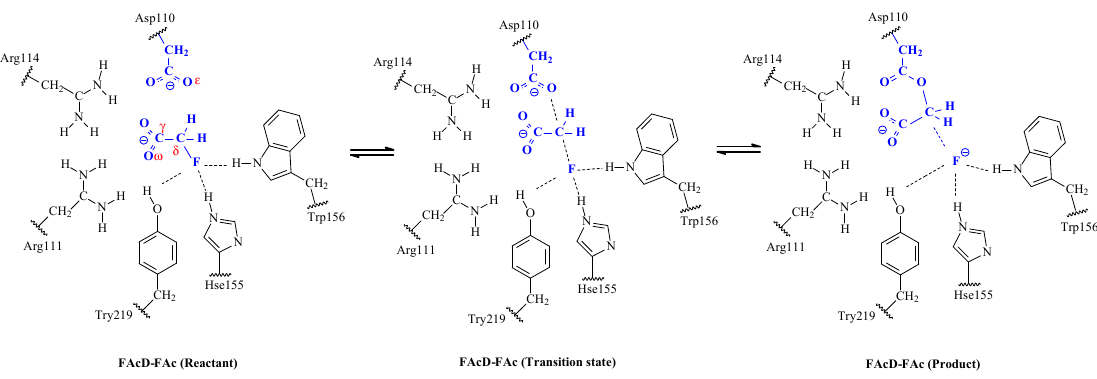
Scheme 1. The dehalogenation process catalyzed by fluoroacetate dehalogenase. The atoms in small quantum mechanics (QM) regions are indicated in bold blue while atoms considered in big QM regions are indicated in black. The boundaries between the QM and molecular mechanics (MM) regions are indicated by wavy